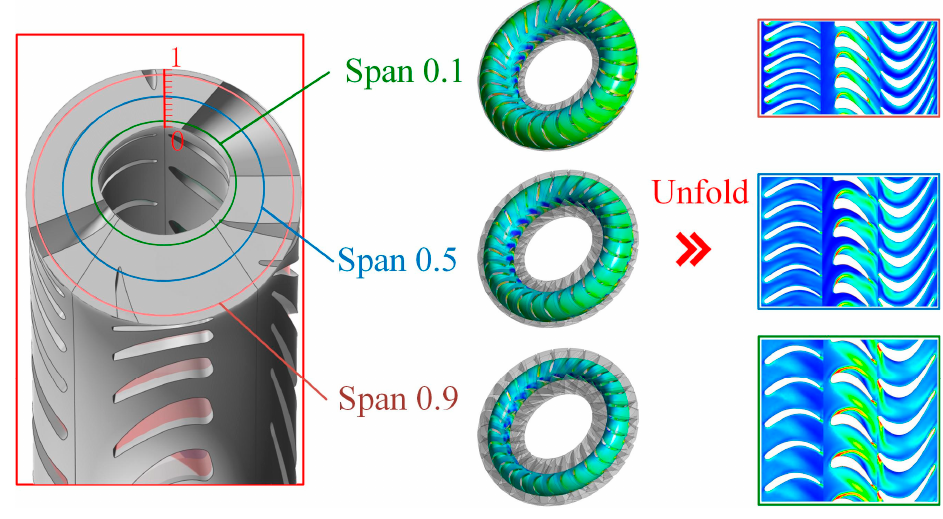
Figure 14. Location of chord